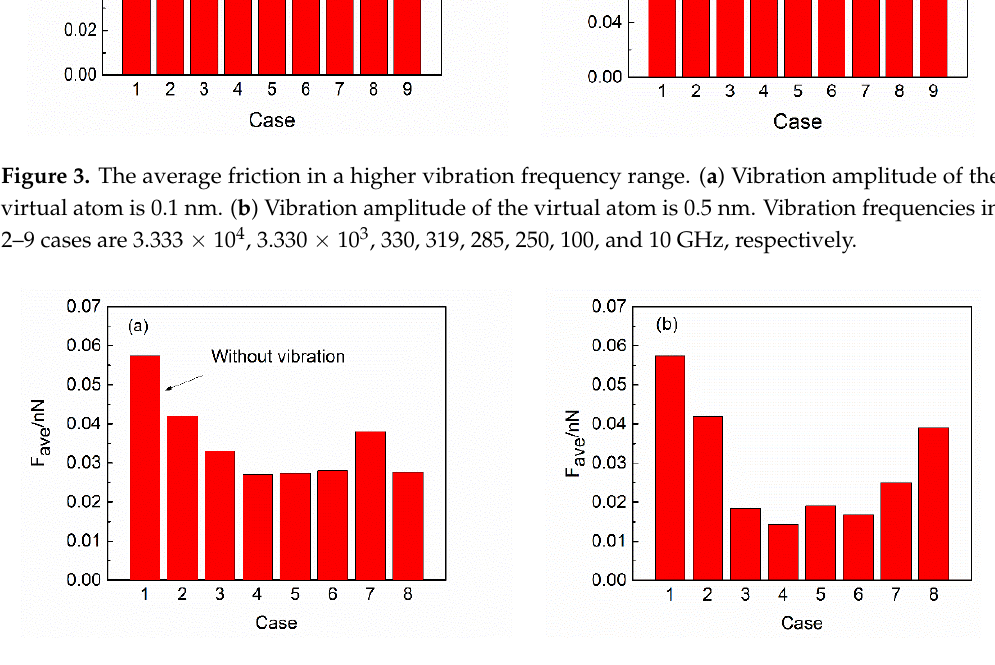
Figure 4. The average friction in lower vibration frequency range. ( a ) Vibration amplitude of the virtual atom is 0.1 nm. ( b ) Vibration amplitude of the virtual atom is 0.5 nm. Vibration frequencies in 2–8 cases are 3.330 × 10 3 , 330, 319, 285, 250, 100, and 10 MHz, respectively.